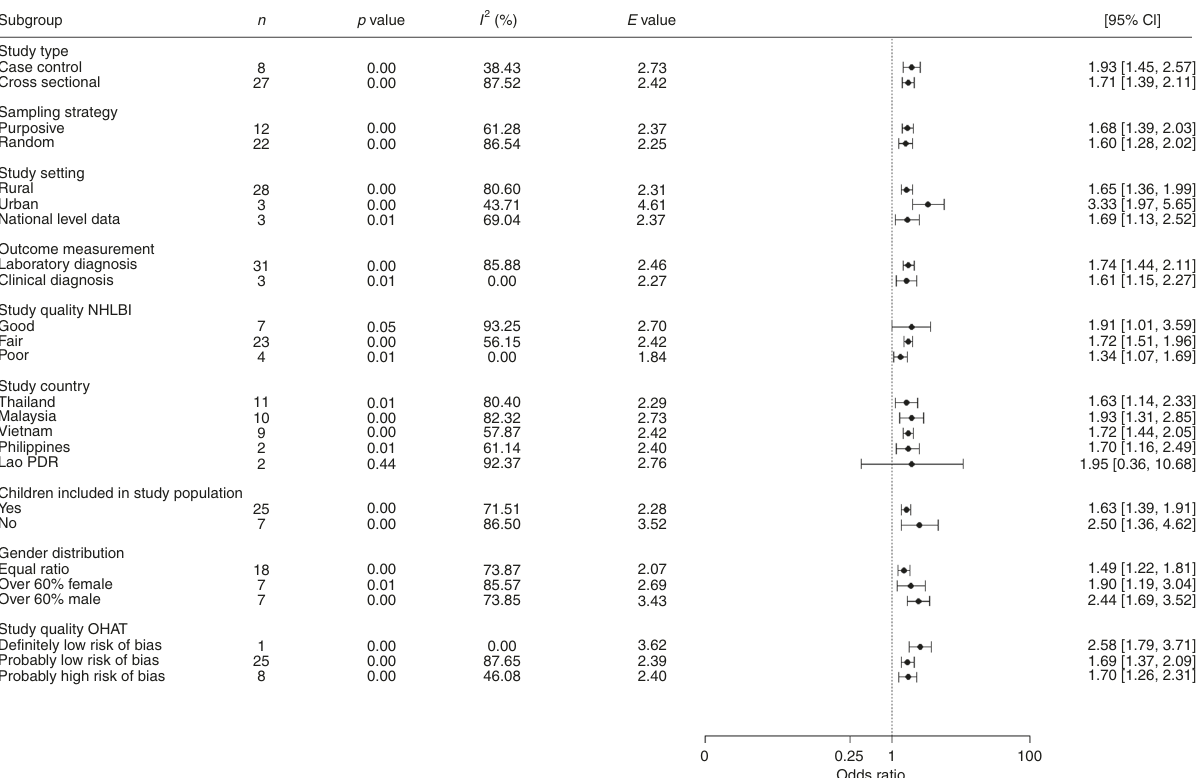
Fig. 4 Sensitivity analysis of the regional meta-analysis. A priori subgroups based on study characteristics to test the sensitivity of the regional meta- analysis. Results suggest that subgroups based on study characteristics do not signi fi cantly alter the direction of the association between occupational or residential exposure to agricultural land-use and infectious disease prevalence. Circle points show the pooled subgroup estimates and error bars are de fi ned as the 95% con fi dence interval. Note: n , number of studies included in each pooled estimate. CI, con fi dence intervals. OHAT, Of fi ce of Health Assessment and Translation. NHLBI, National Heart, Lung and Blood